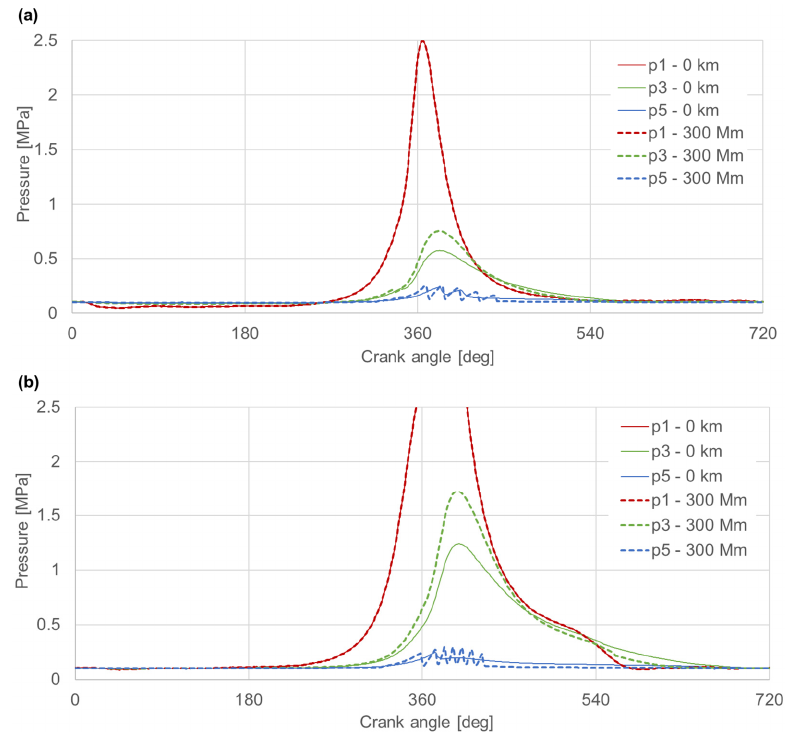
Figure 8. Pressure in the inter-ring spaces for different wear and loads: ( a ) engine load 20 Nm; ( b ) engine load 168 Nm.